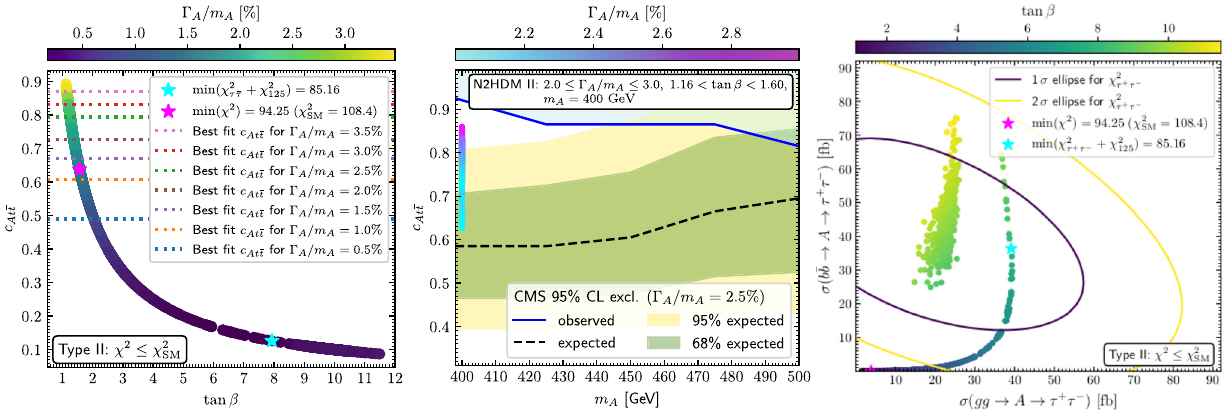
Fig. 2 Left: c At ¯ t in dependence of tan β . The colors of the points indi- cate the value of (cid:8) A / m A in %. The dashed horizontal lines indicate the best-fit values of c At ¯ t for different width hypotheses in the exper- imental analysis [6]. Middle: Values of c At ¯ t for the parameter points with 2 . 0% ≤ (cid:8) A / m A ≤ 3 . 0% in comparison to the observed (blue) and expected (black dashed) upper limits at the 95% CL as well as the corresponding 1 σ (green) and 2 σ (yellow) regions around the expected limit assuming (cid:8) A / m A = 2 . 5%, as published in Ref. [6]. Right: Signal Fig. 3 χ 2 (blue) and χ 2 τ + τ − t ¯ t + χ 2 (orange) and χ 2 τ + τ − t ¯ t (green) in dependence of tan β . The horizontal blue, orange and green dashed lines indicate the value of χ 2 , χ 2 and SM ,τ + τ − SM , t ¯ t + χ 2 χ 2 , SM ,τ + τ − SM , t ¯ t